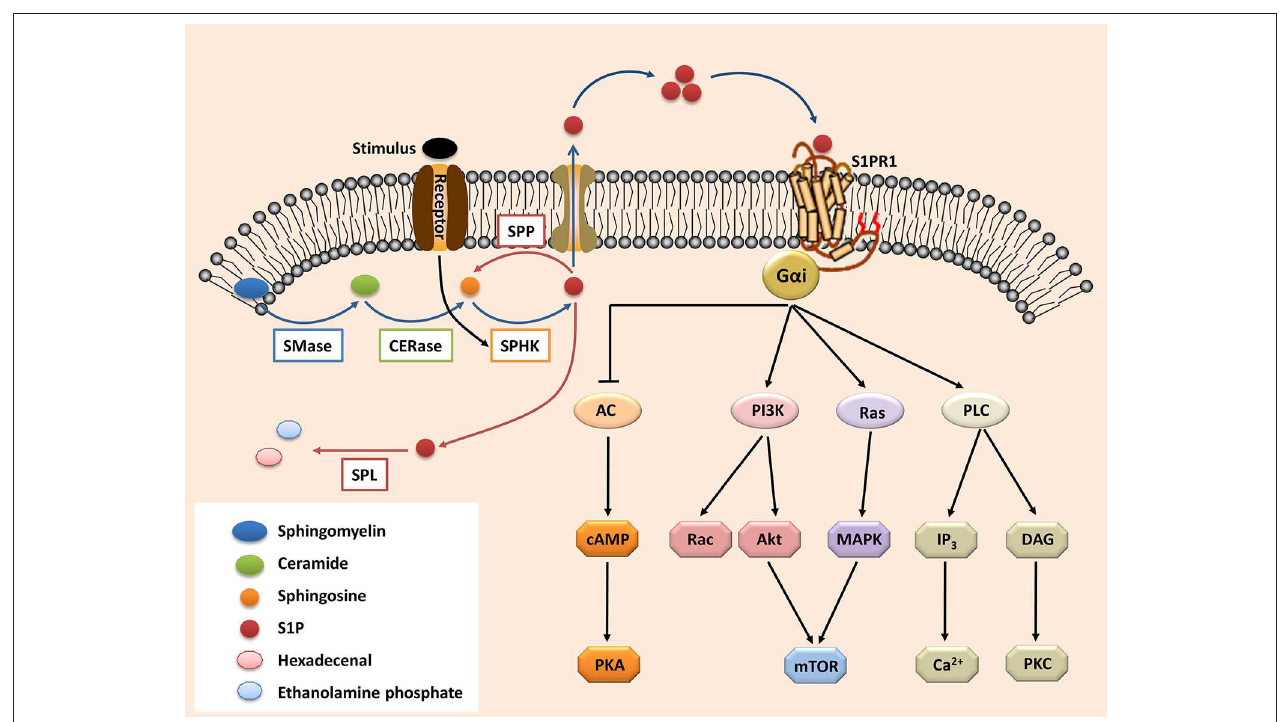
FIGURE 1 | The S1P-S1PR1 signaling. Sphingolipid (derived from cell membrane) is cleaved (by sphingomyelinases, SMase) to ceramide. Ceramide is then deacylated by ceramidases (CERase) to produce sphingosine. S1P is produced by phosphorylation of sphingosine, which is mediated by SPHKs (SPHK1 and SPHK2, which can be activated by certain stimulus). S1P can be reversibly degraded by S1P phosphatases (SPPs), or irreversibly degraded by S1P lyase (SPL). On the other hand, S1P can be transported outside the cells and acts in the autocrine or paracrine manners to activate its receptor S1PR1. The S1PR1 then activates